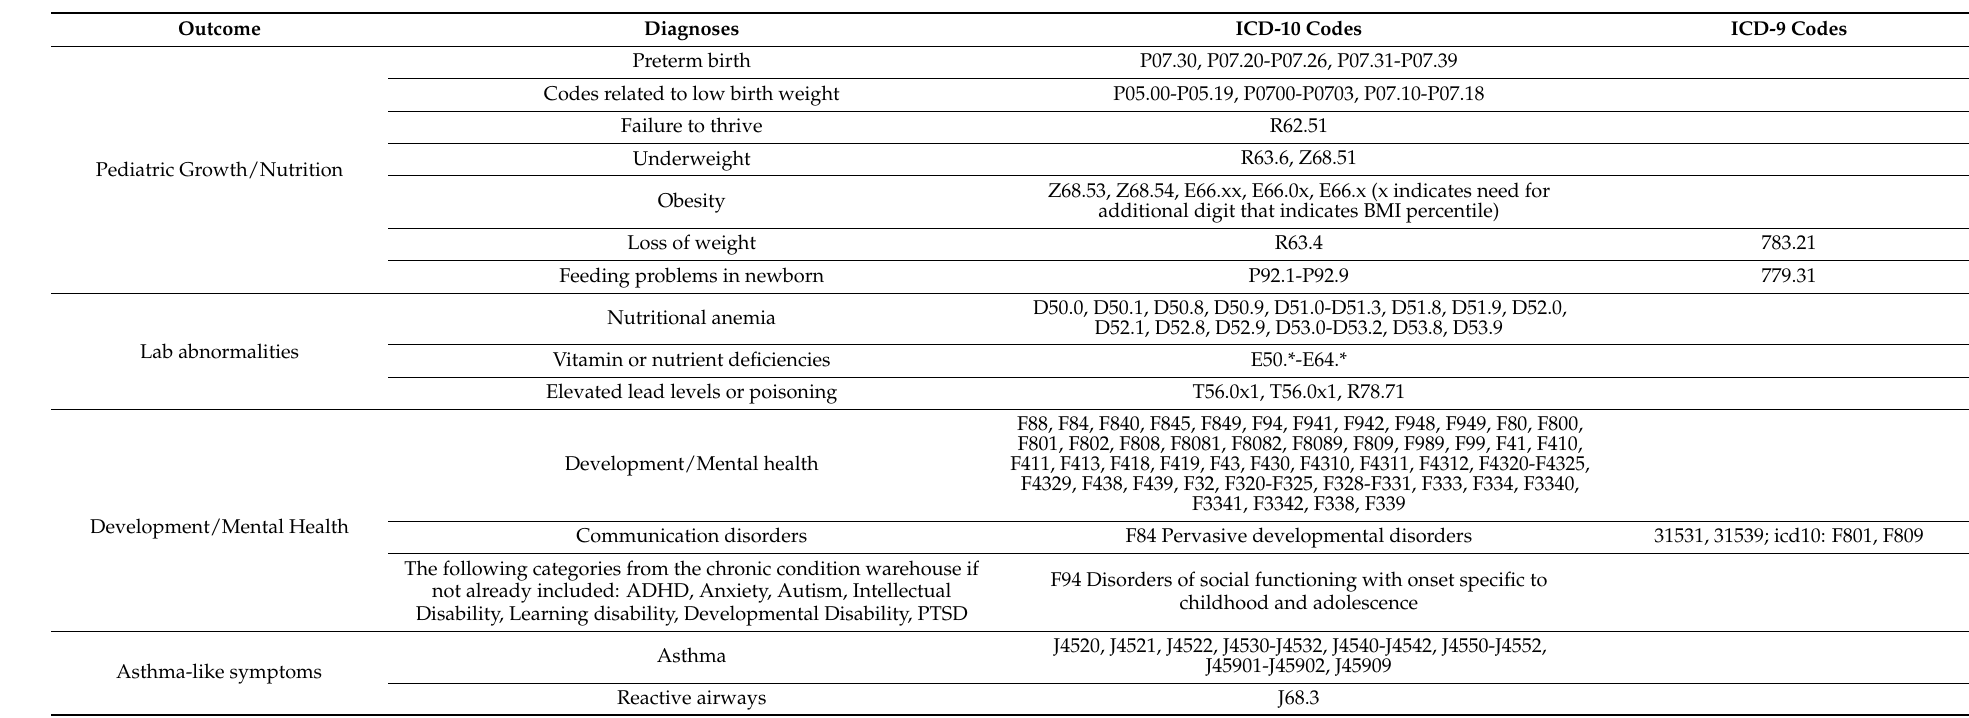
Table A3. ICD-10 and ICD-9 codes used to develop child outcomes from electronic health